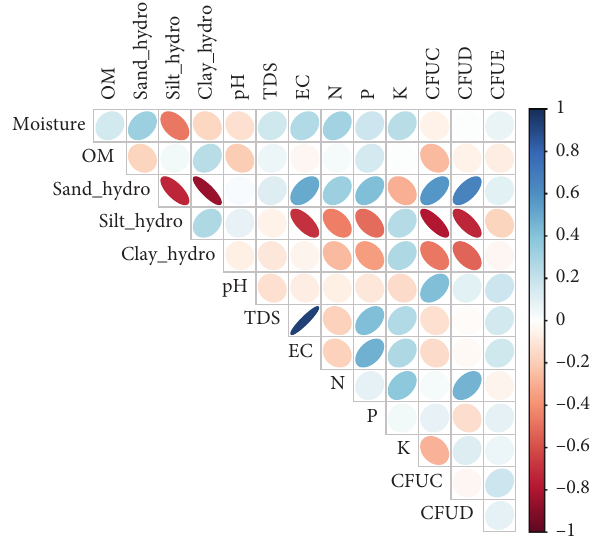
Figure 6: Correlation matrix of data from the soil classification